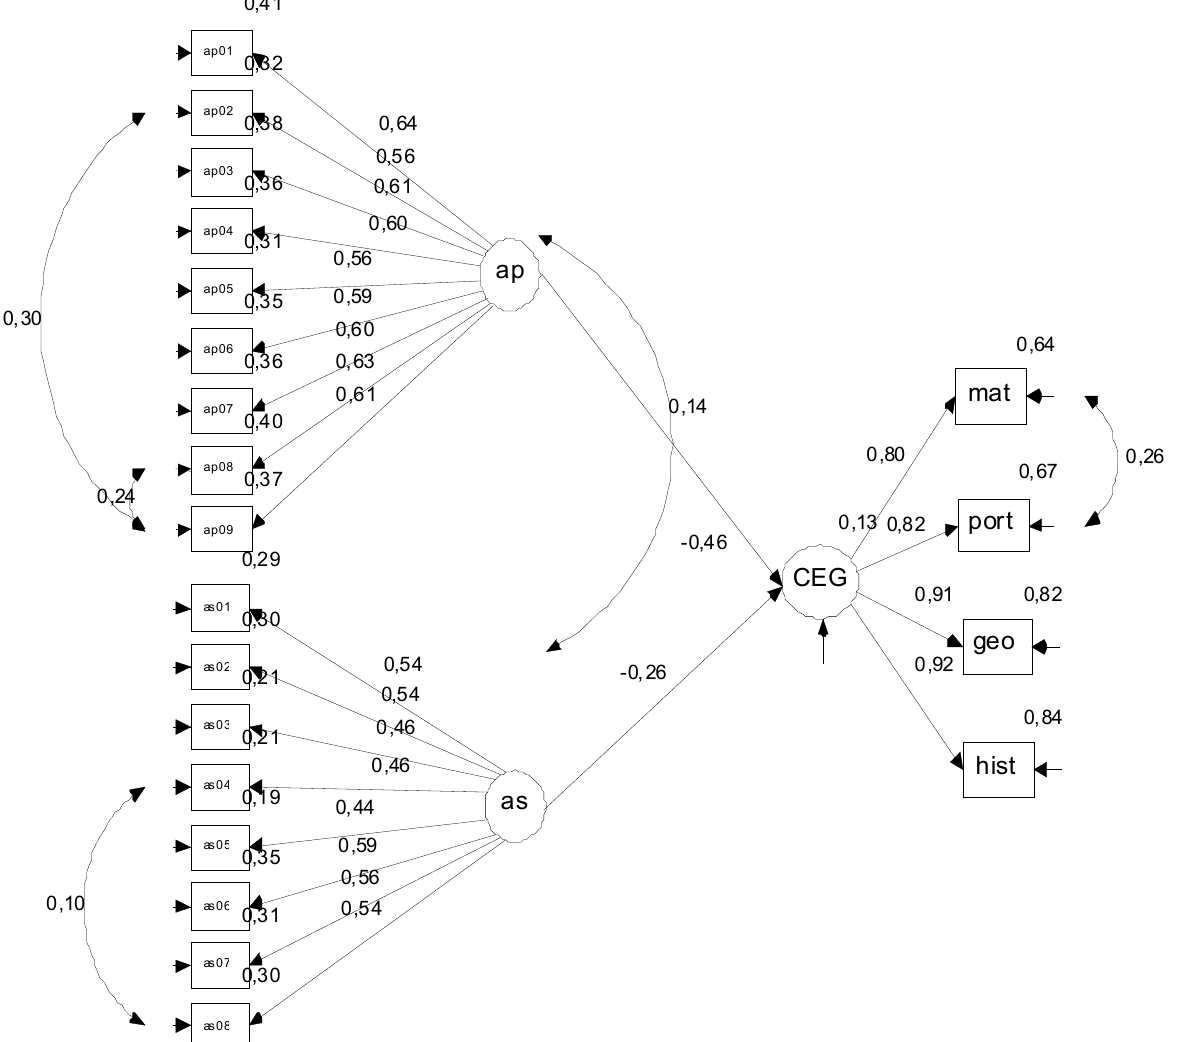
Figura 1 . Modelo Explicativo das Relações entre as Variáveis Latentes e as Variáveis Manifestas do Estudo – Cargas Fatoriais, Correlações e Variância Explicada da Amostra